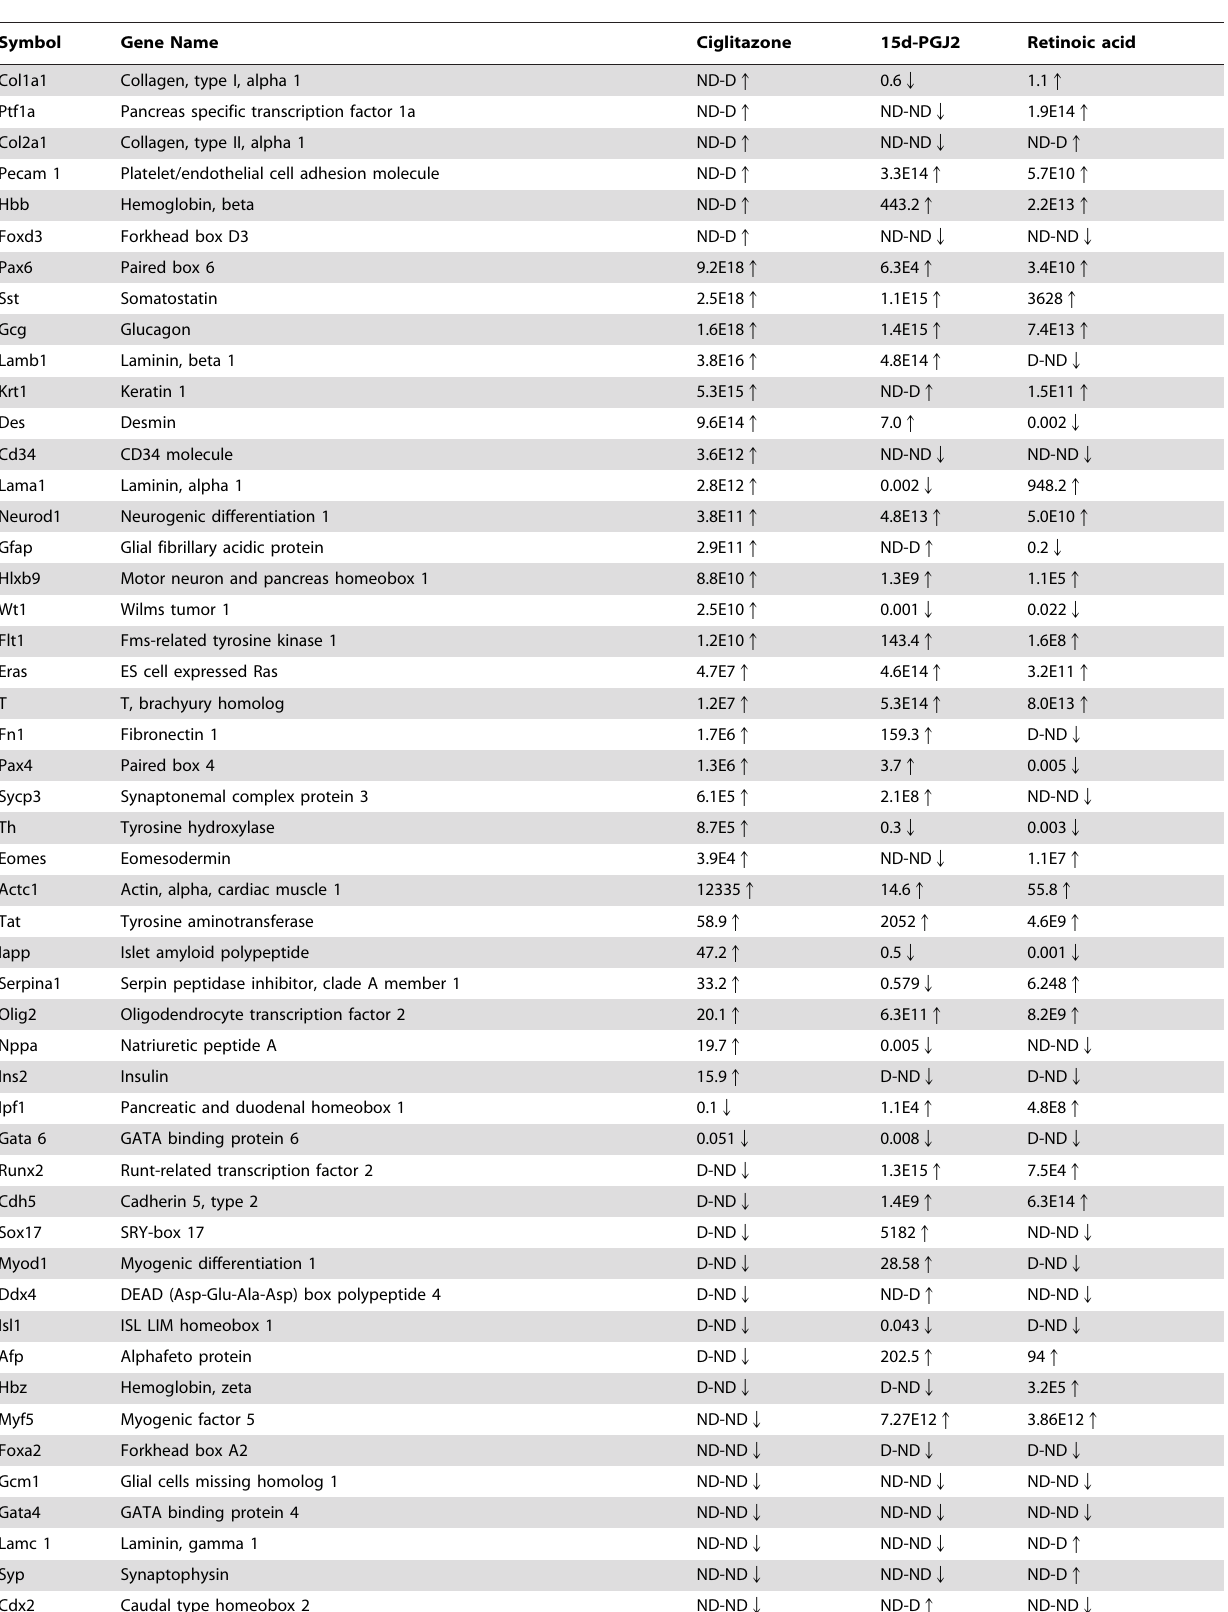
Table 2. Regulation of differentiation gene profile by PPAR c agonists in neural stem cells.